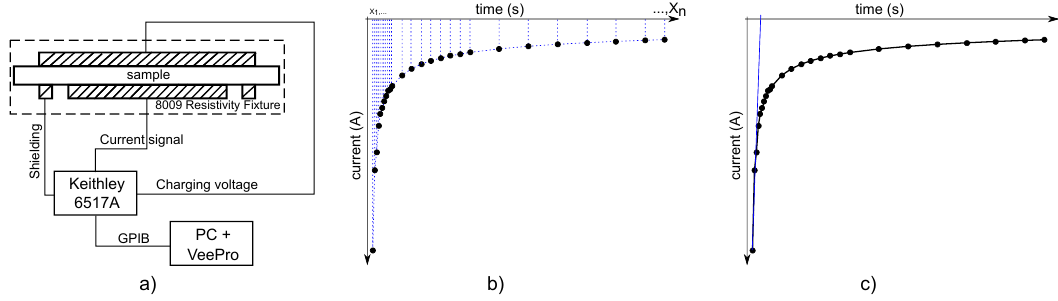
Figure 10. Resorption current analyses ( a ) measurement circuit; ( b ) are over the curve determination by trapezoid integration; ( c ) time constant determination by tangent